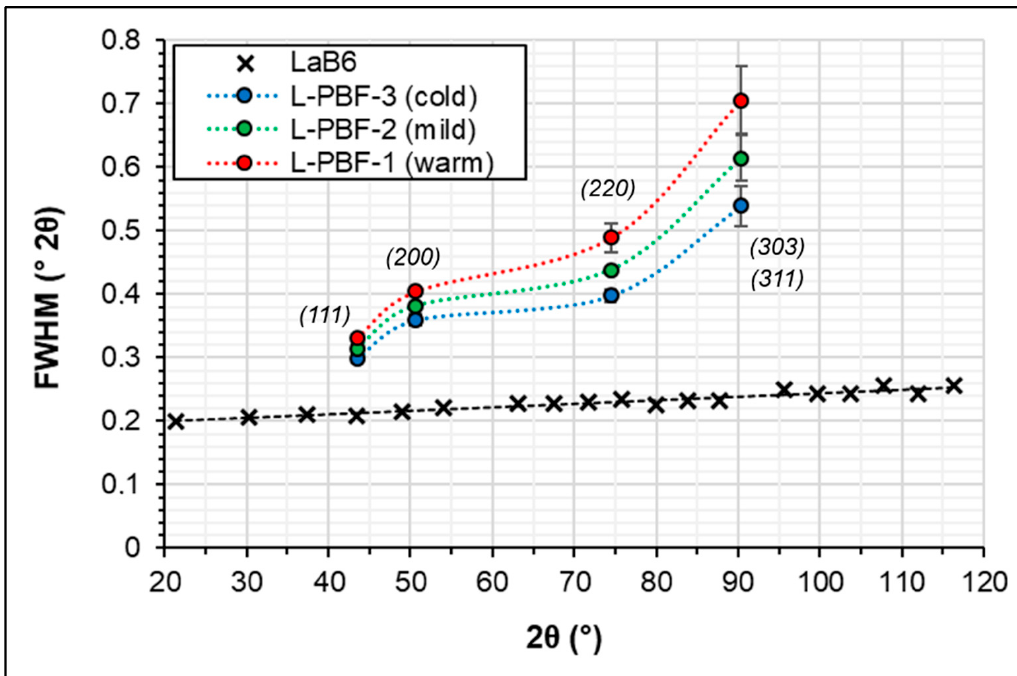
Figure 8. Differences in peak broadening between the various specimens compared to the experimental uncertainty measured on a reference (LaB6 powder).